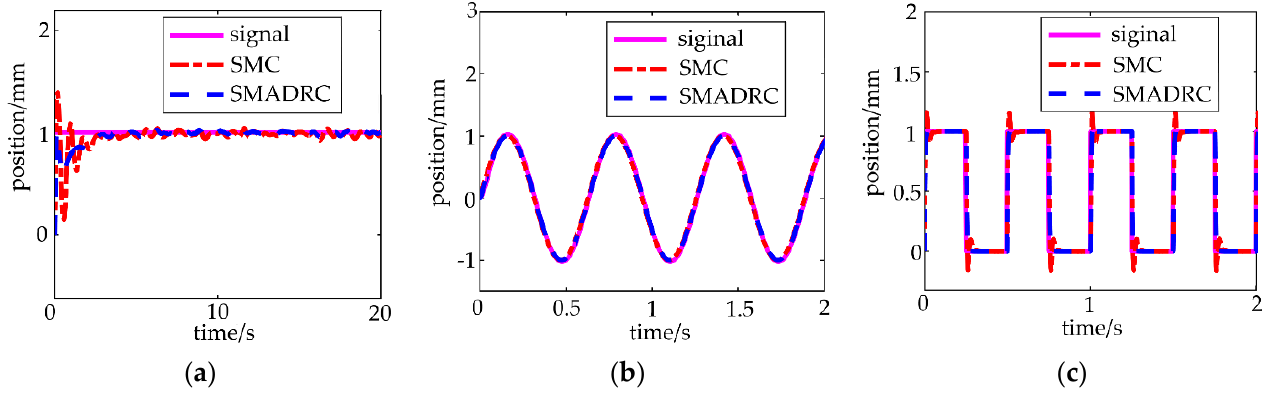
Figure 3. Trajectory tracking variation under the different controllers. ( a ) Step signal trajectory tracking, ( b ) sign signal trajectory tracking, ( c ) square wave signal trajectory tracking.